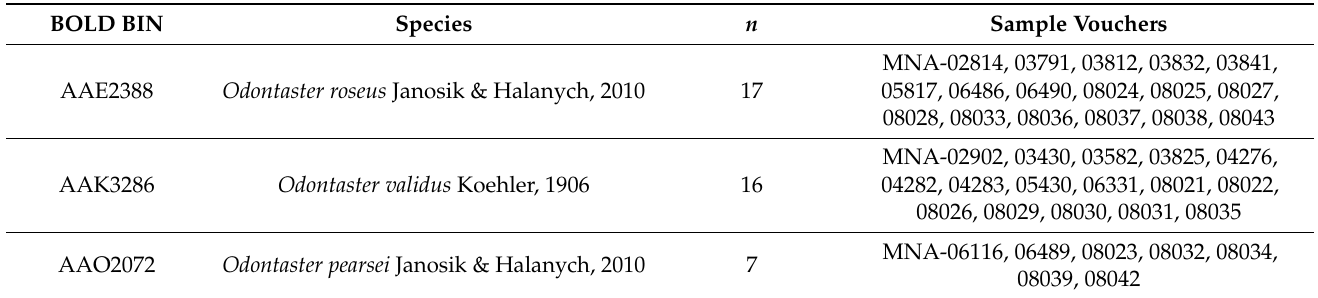
Table 3. Samples species partition and associated BOLD BIN. Abbreviations: barcode index number (BIN); number of samples ( n